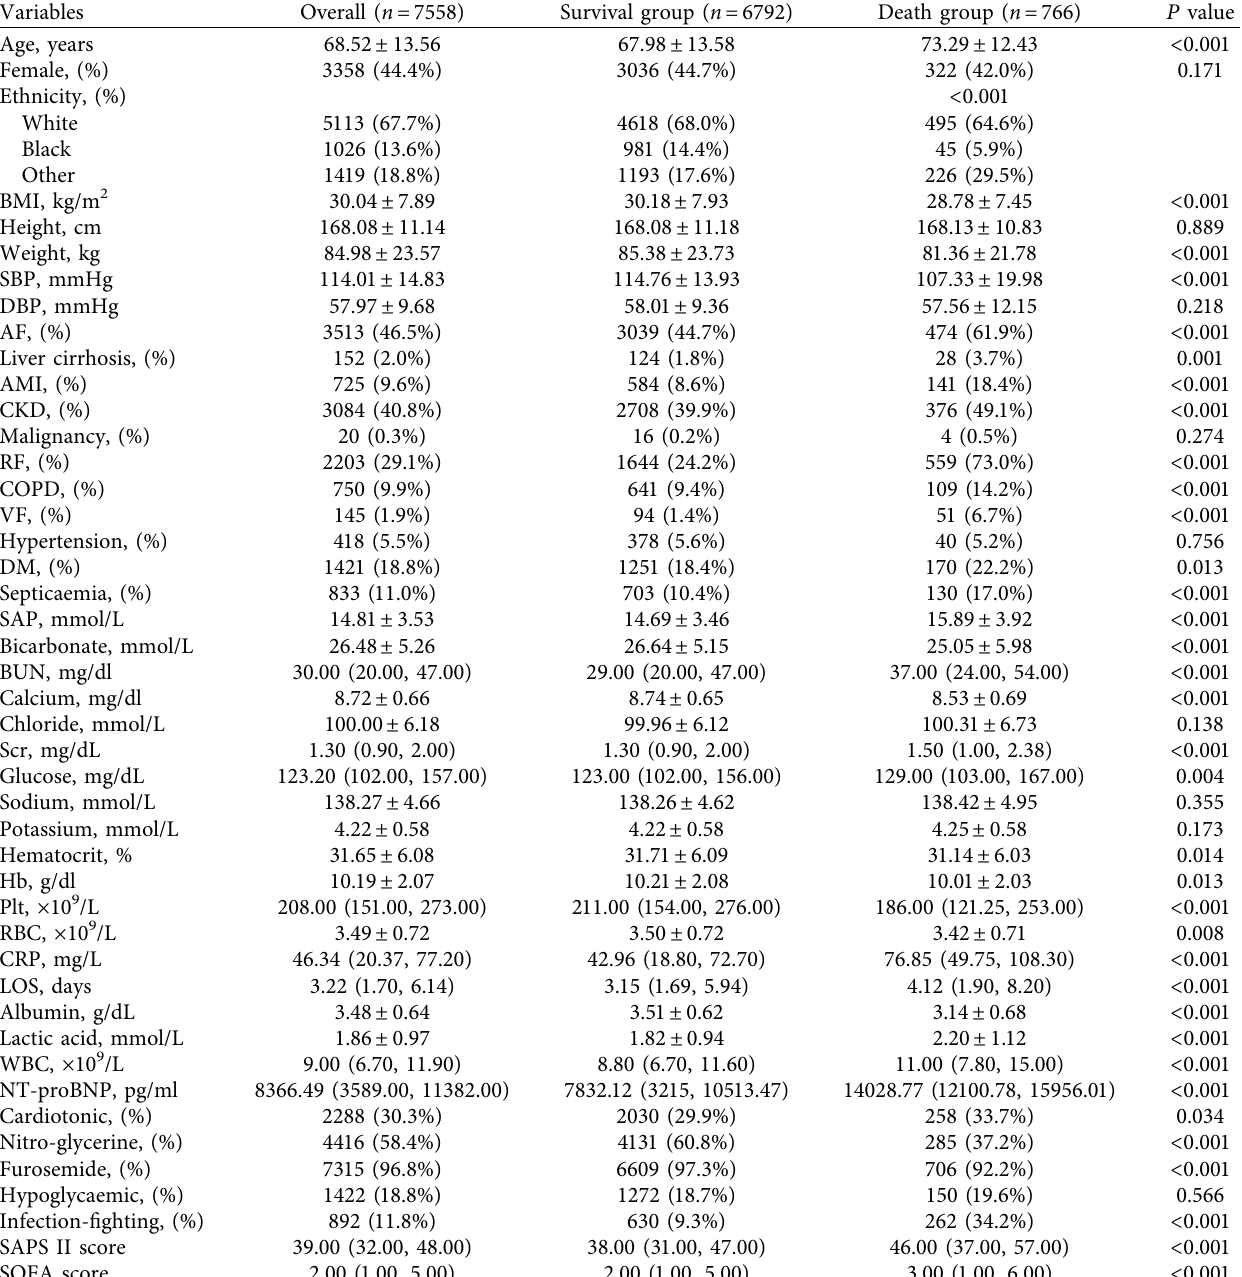
Table 1: Baseline characteristics of the AHF patients on